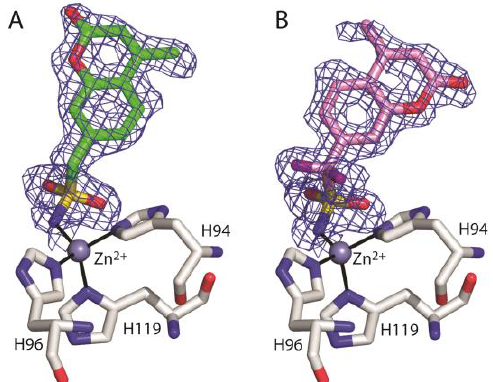
Figure 3. σA -weighted (|2F o -F c |, ϕ c ) simulated annealing omit map (contoured at 1.0 σ) relative to Figure 3. σ A-weighted (|2F o -F c |, φ c ) simulated annealing omit map (contoured at 1.0 σ ) relative to the inhibitor molecule in the hCA II/ 1 ( A ) and hCA II/ 2 ( B ) complexes. the inhibitor molecule in the hCA II/ 1 ( A ) and hCA II/ 2 ( B )